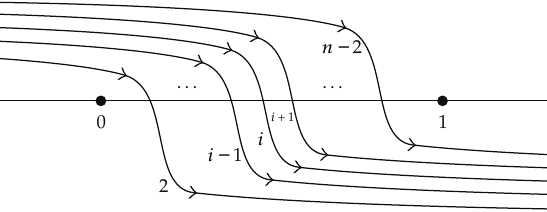
Figure 1: The nested structure of the contours of integration for the v − < v (cid:8) < ··· < v (cid:8) < 1 of the v (cid:8) ordering 0 < v (cid:8) 2 3 n − 2 i